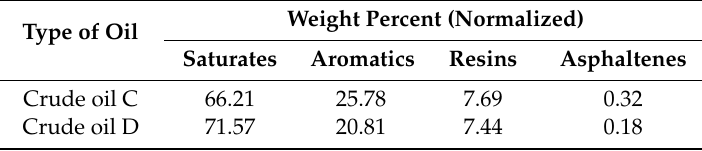
Table 4. Saturates, aromatics, resins, asphaltenes (SARA) analysis of crude